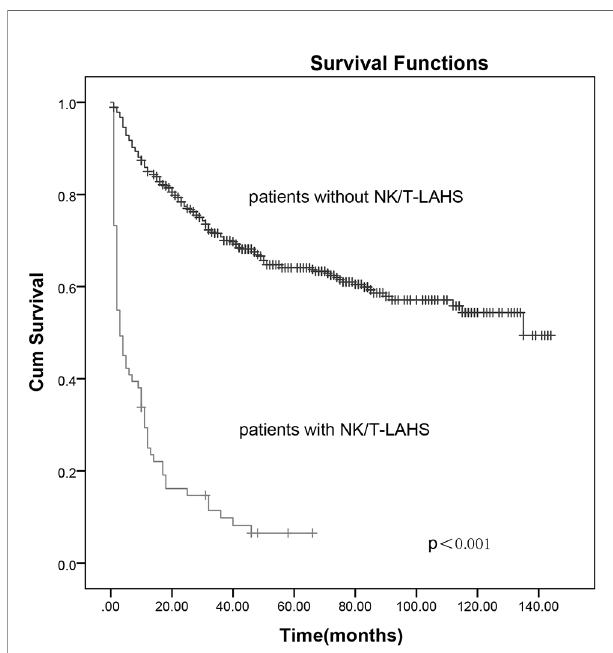
FIGURE 2 | The 2-year overall survival curves for patients with and without extranodal nature killer/T-cell lymphoma-associated hemophagocytic syndrome.